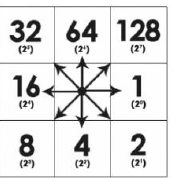
Figure 7. The coding of the direction of flow in the D8 flow model.